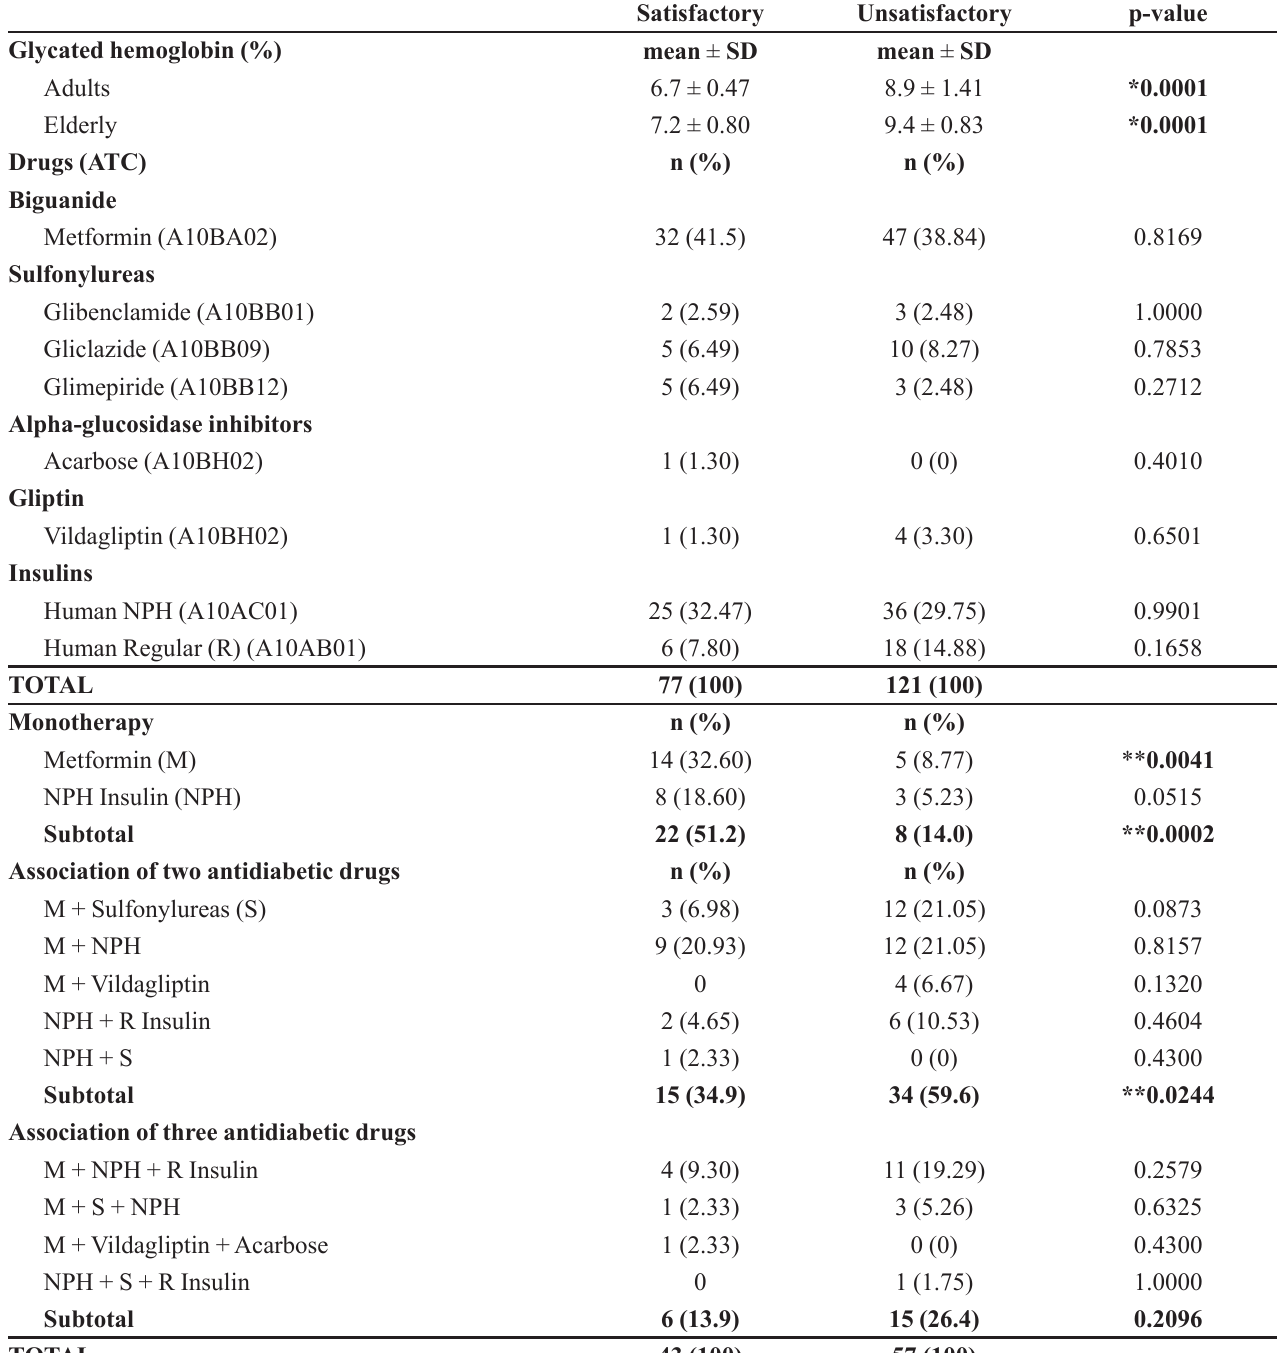
TABLE II - Frequency of drugs prescribed for type 2 Diabetes mellitus according to glycemic